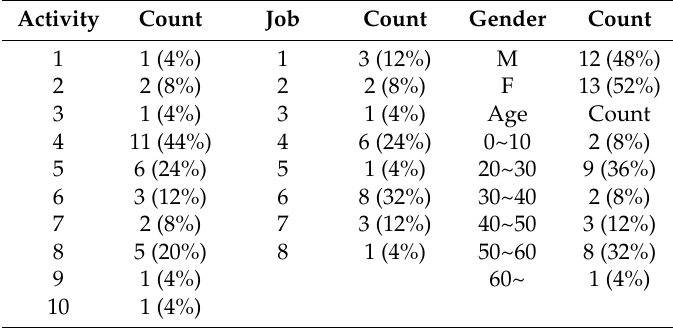
Table 6. Data specification.